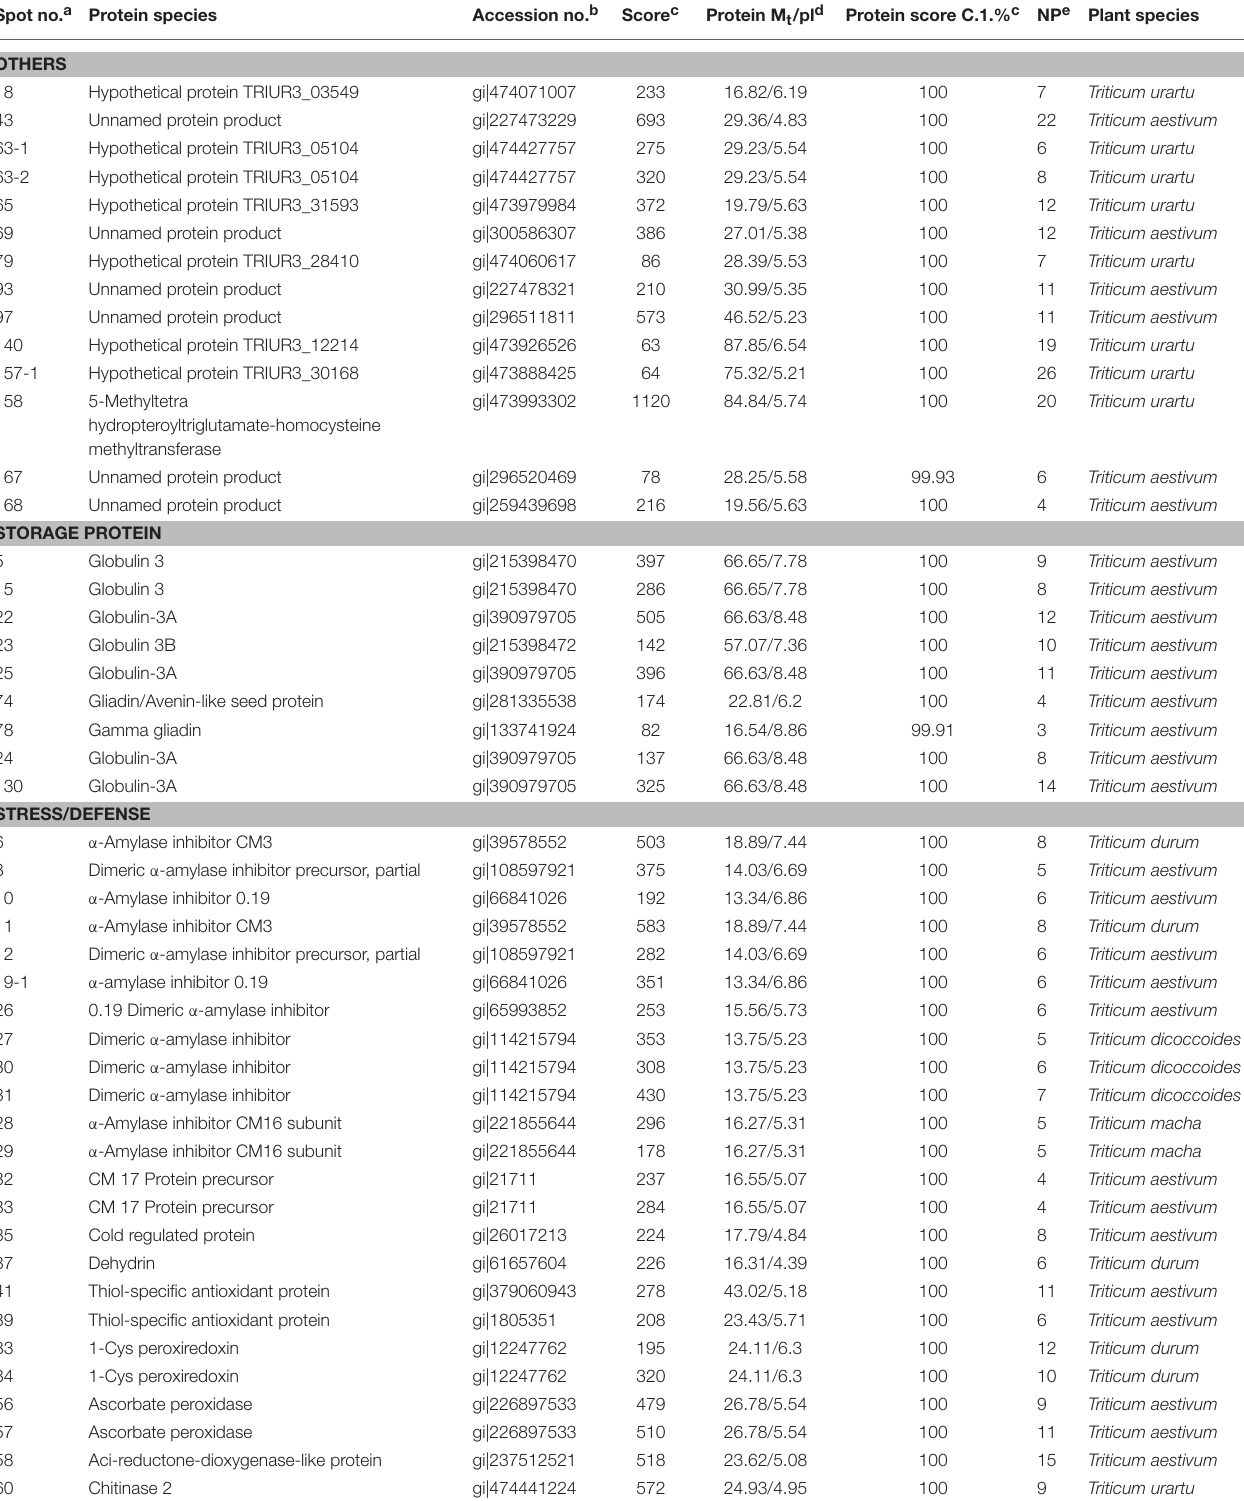
TABLE 2 | Differentially expressed proteins identified by MALDI-TOF/TOF-MS at four grain developmental stages in bread wheat cultivars Yunong 201 and Yunong 3114. Spot no. a Protein